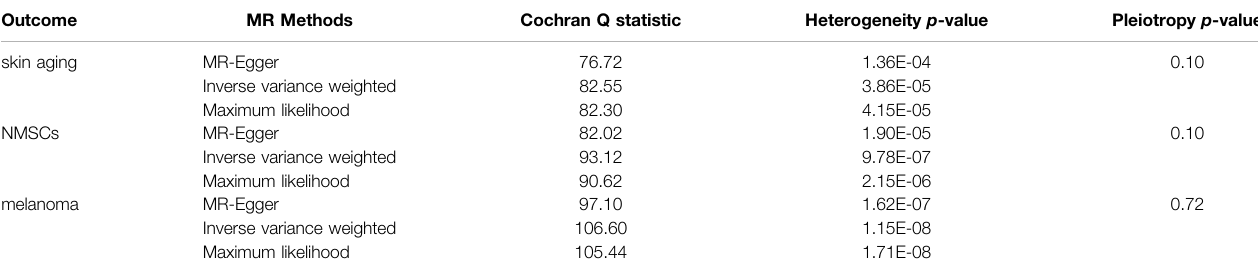
TABLE 3 | Heterogeneity and pleiotropy analysis by MR Egger, IVW, Maximum likelihood.